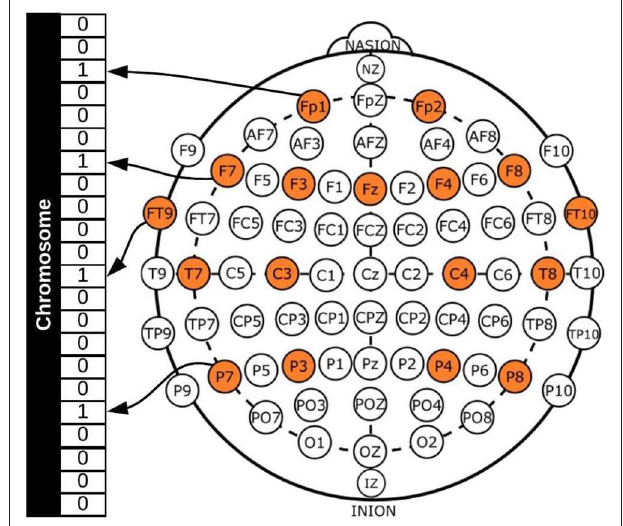
FIGURE 1 | Example of channel representation in a chromosome for a